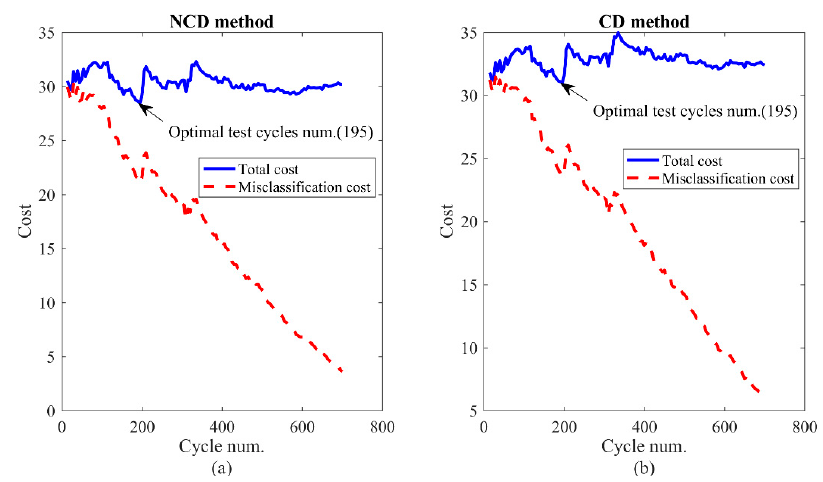
Figure 14. Cost versus cycle number of NCD and CD methods.